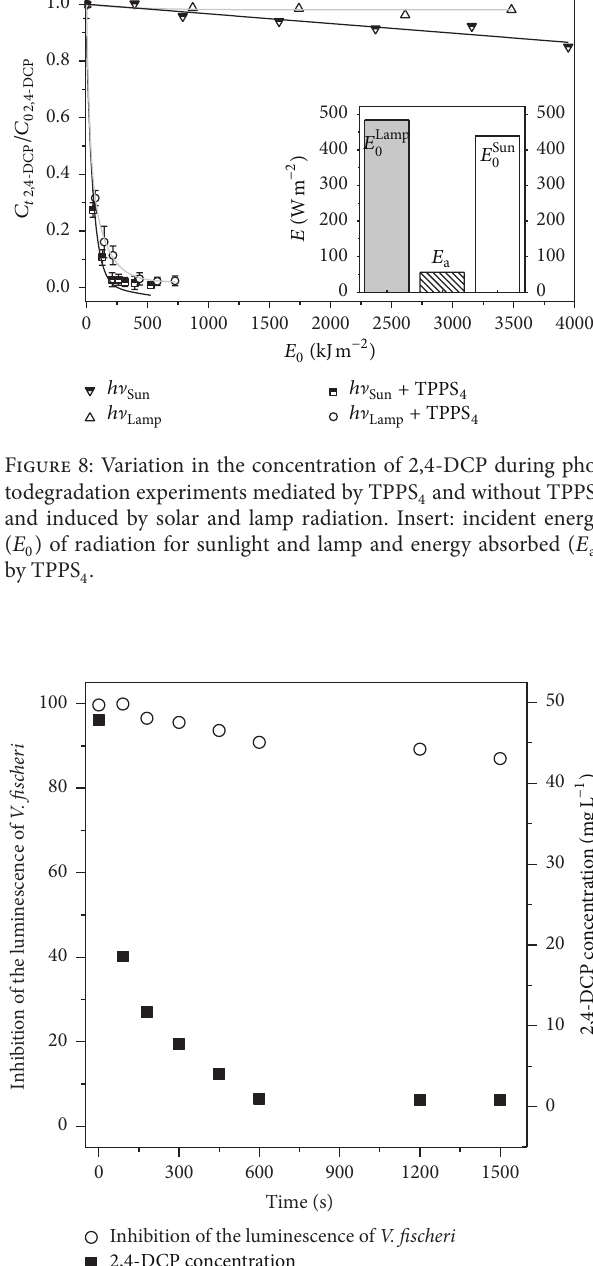
The determined EC 50 values are presented in Table